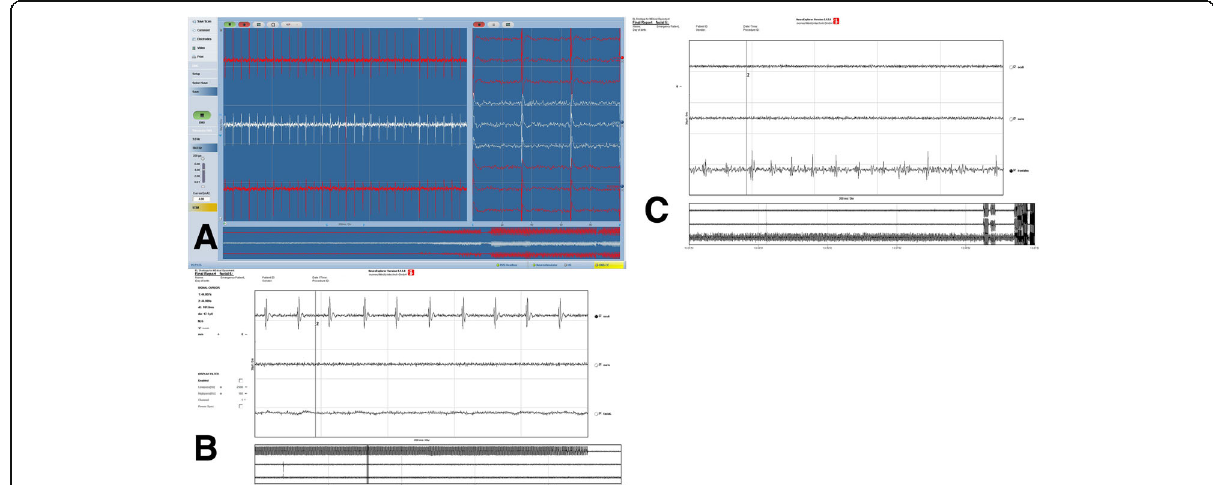
Fig. 2 Action potential for facial muscles: single or multiple. a Action Potential of the three muscles [occuli, oris and frontalis]. b Action Potential of single facial muscle [occuli]. c Action Potential of single facial muscle [frontalis]